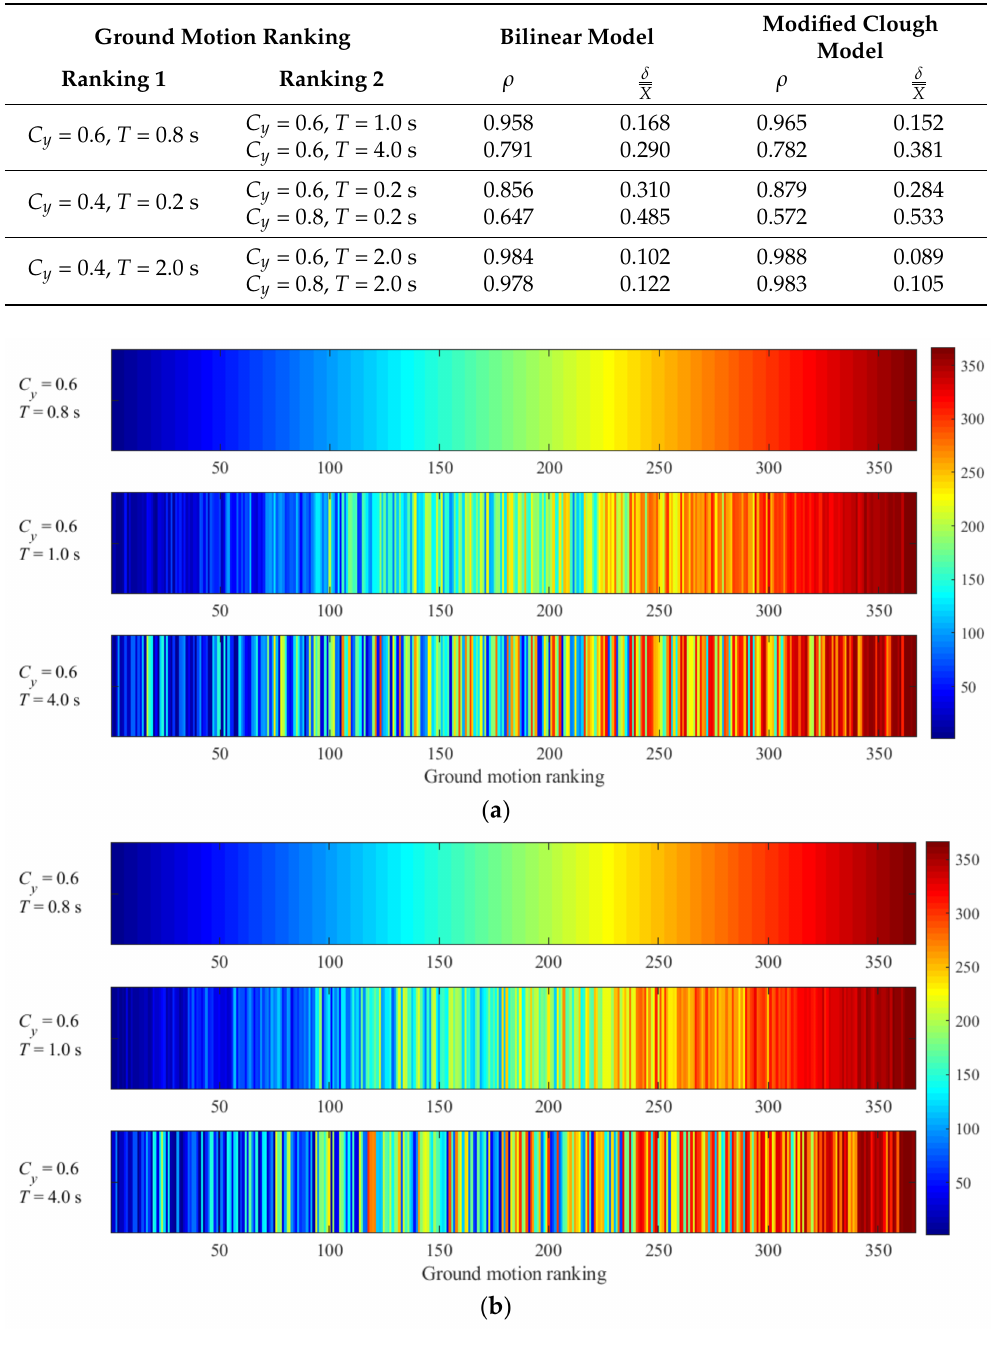
Table 2. Correlation and discreteness of earthquake potential damage potential ranking under different C y and T .